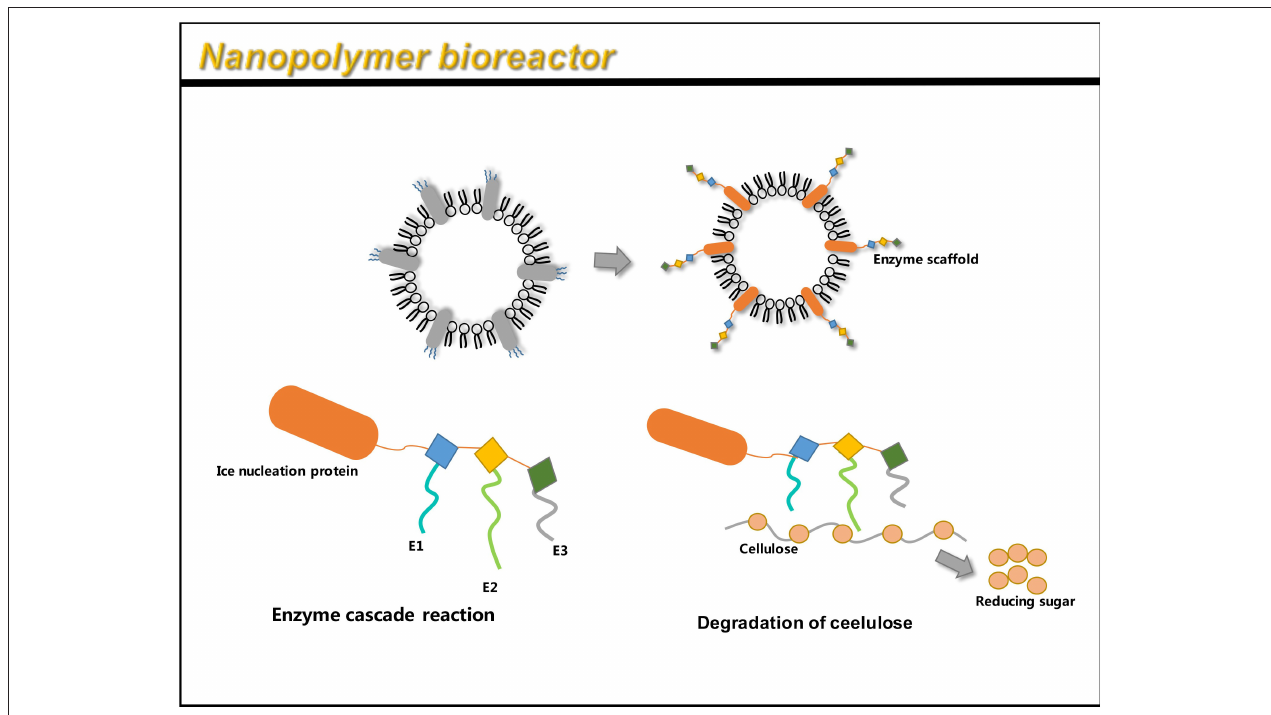
FIGURE 6 | OMV can be linked to an enzyme scaffold through gene functions to connect three enzyme molecules that can complete a complete set of reactions. Through the action of enzymes, cellulose is successfully hydrolyzed to reduce